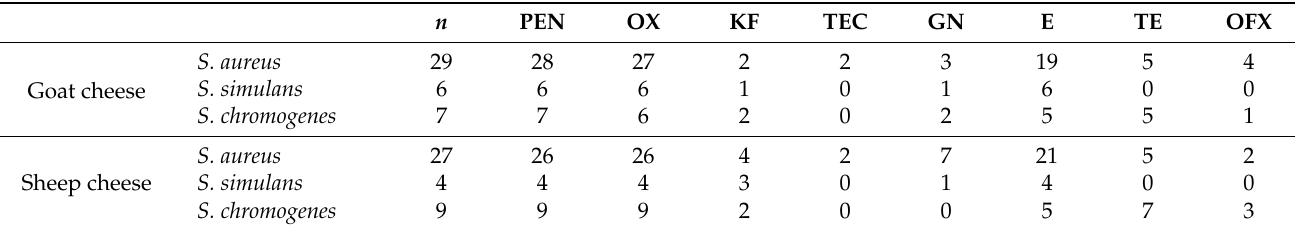
Table 4. Number of resistant isolates isolated from goat and sheep cheese.